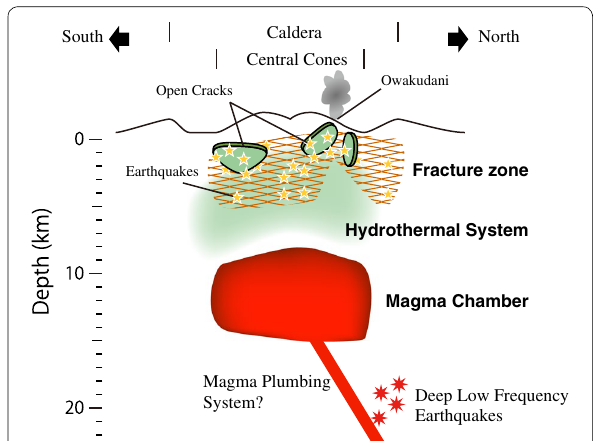
Fig. 21 Schematic model of the magma-hydrothermal system of Hakone volcano inferred from seismic tomography and observation during the 2015 unrest and eruption (after Yukutake et al. 2015). North–south section of the system is shown. Thickness of open cracks is not to